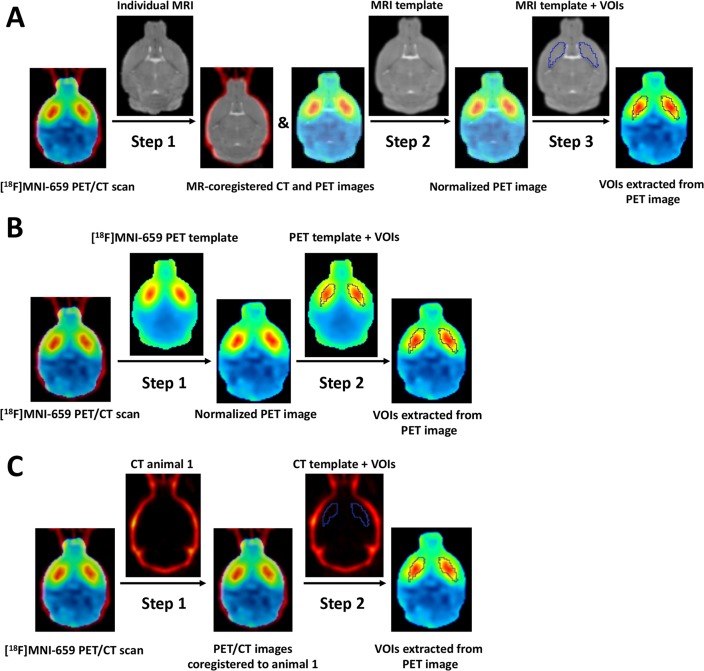
Schematic overview of spatial normalization approaches for [18F]MNI-659 regional quantification.(A) MRI template-based spatial normalization: CT images were co-registered to their individual T2-weighted MR image through a rigid body transformation and the same transformation was applied to the PET images (Step 1). Then a non-linear warping of the individual MR images to MRI template was performed (Step 2). The same transformation was applied to the [18F]MNI-659 PET images in order to obtain the PET images normalized to the MRI templates for extraction of the TACs from the VOIs (Step 3). (B) PET template-based spatial normalization: [18F]MNI-659 PET images were normalized through a non-linear warping to the PET template (Step 1) and TACs were extracted from the VOIs (Step 2). (C) CT template-based spatial normalization: CT images were co-registered to the CT of the first animal through a rigid body transformation and the same transformation was applied to the PET images (Step 1). Finally, TACs were extracted from the VOIs (Step 2). Unmasked PET images were used for both spatial normalization approaches, however, for visual clarity, masked images are shown. TACs = time-activity curves.